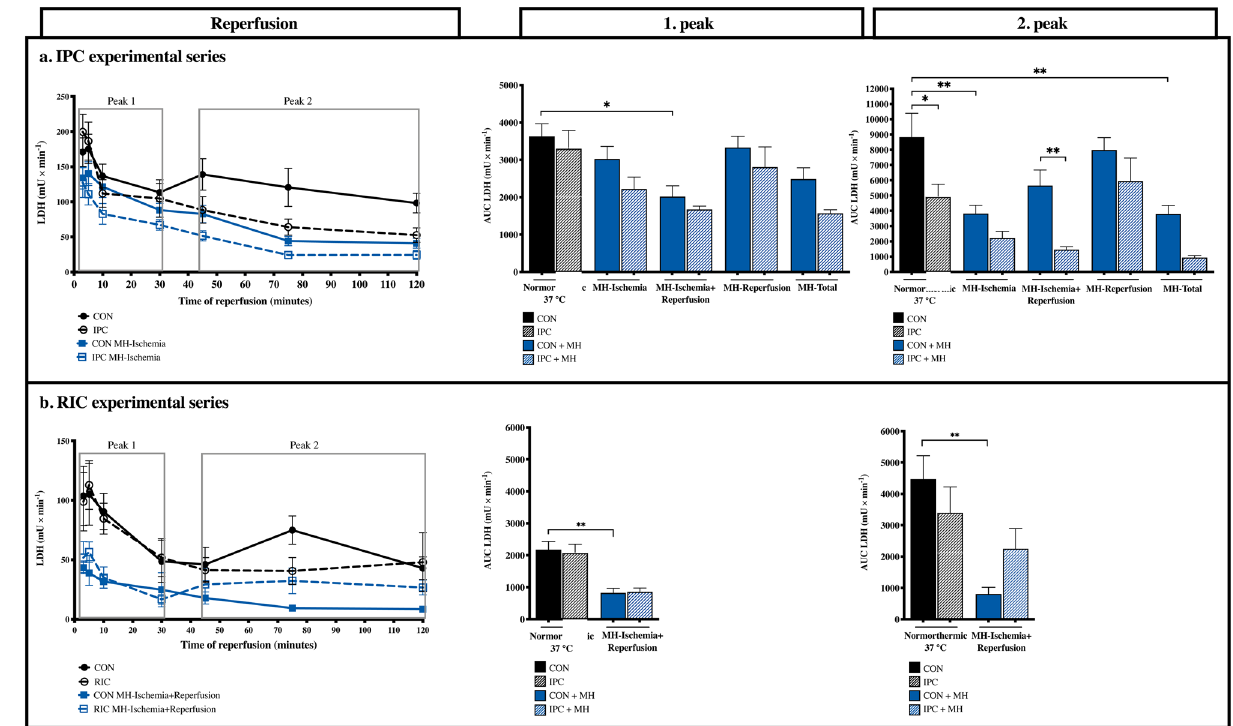
Figure 3. LDH release. ( a ) IPC experimental series, ( b ) RIC experimental series. LDH Lactate dehydrogenase, AUC area under the curve, CON control, IPC ischemic preconditioning, RIC remote ischemic preconditioning, MH-Ischemia mild hypothermia during ischemia, MH-Ischemia + Reperfusion mild hypothermia during last 20 min of ischemia and throughout reperfusion, MH-Reperfusion mild hypothermia during reperfusion, MH-Total mild hypothermia through the total protocol. *p < 0.05, **p <